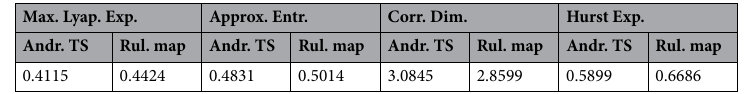
Table 5. Chaotic descriptors: Android time series versus Rulkov map modelling.